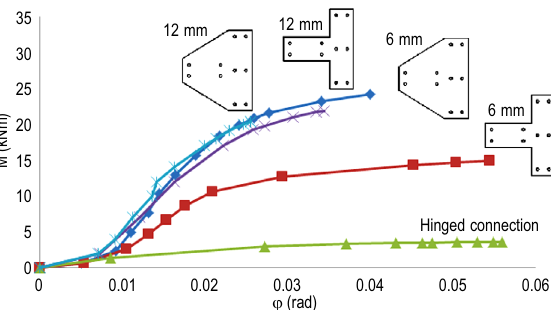
Fig. 11. Results of the connections of C150×40×2.5